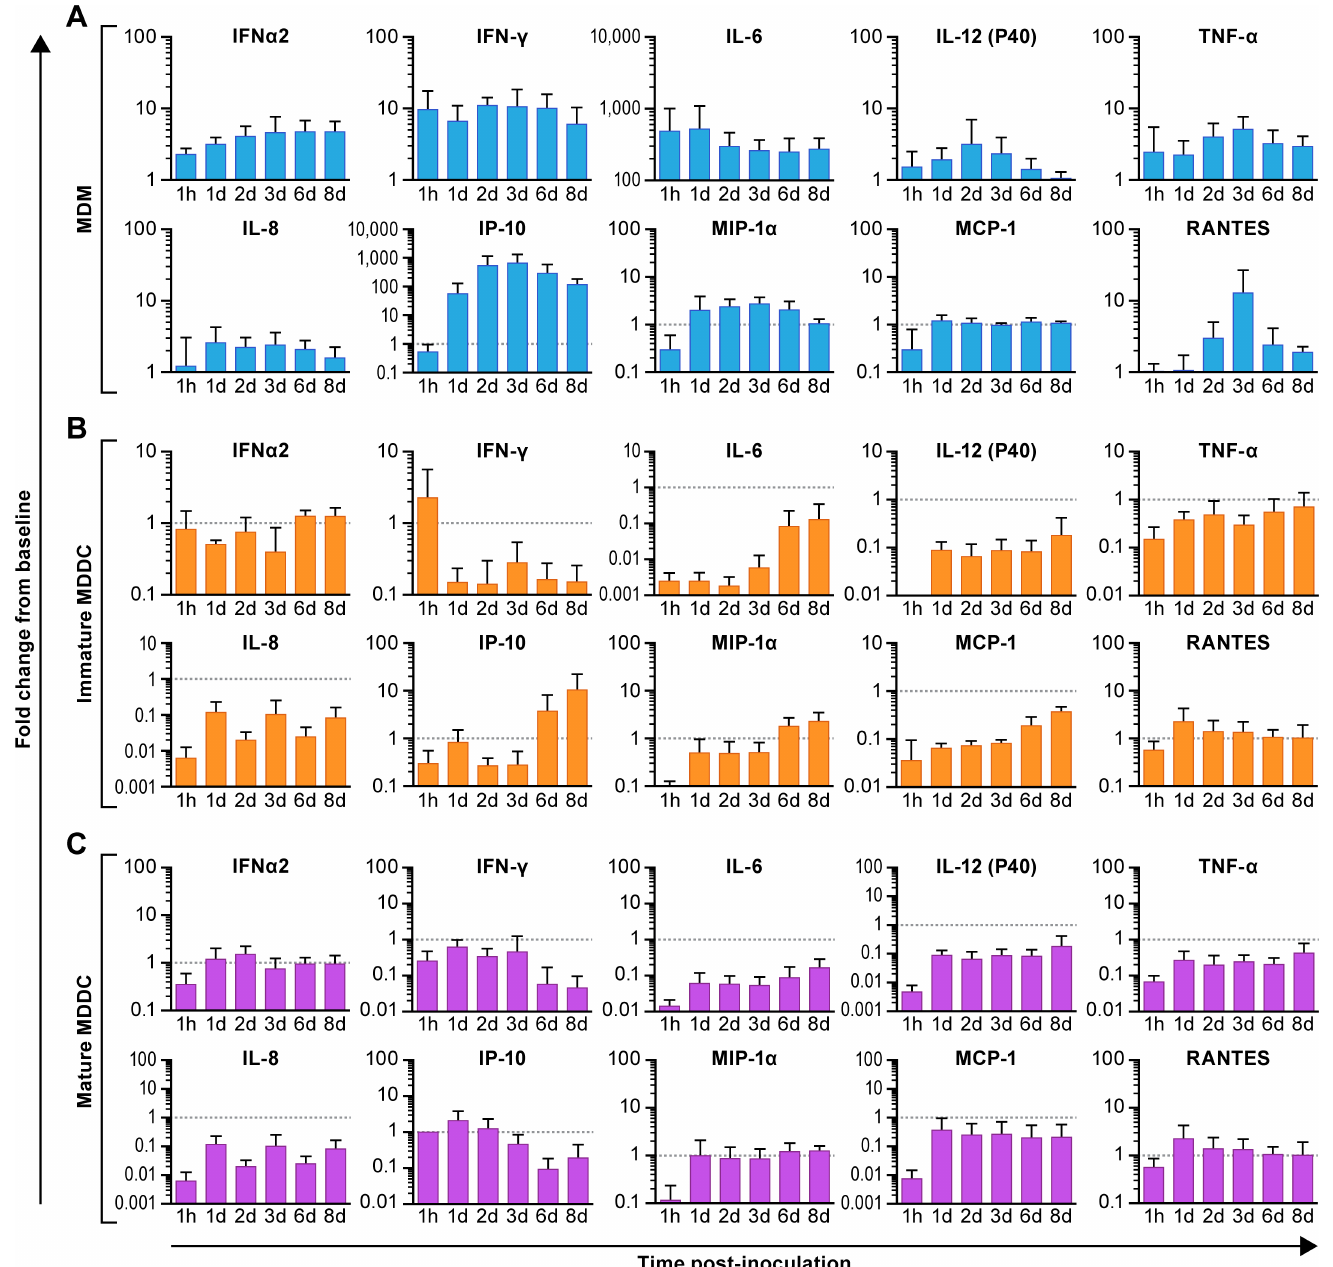
Fig 3. Cytokine and chemokine responses to MERS-CoV infection from certain innate immune primary cells. (A) Human macrophages (MDMs) (B), immature monocyte-derived (MDDCs), and (C) mature MDDCs were inoculated with MERS-CoV Jordan variant at an MOI = 2 or subjected to mock infection. From cell culture supernatants, the fold change in immunoregulatory cytokines and chemokines relative to that of mock-infected cells incubated for the same period of time, were determined by multiplex assay. All data points represent triplicate biological replicates from four donors.